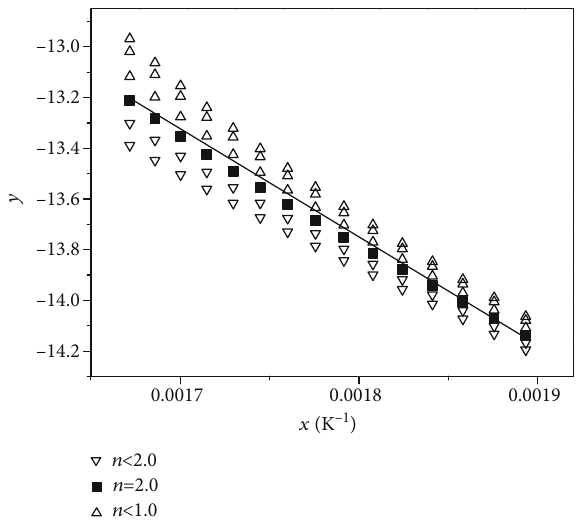
Figure 7: Pine tar combustion kinetic characteristics at 254-331 ° C.